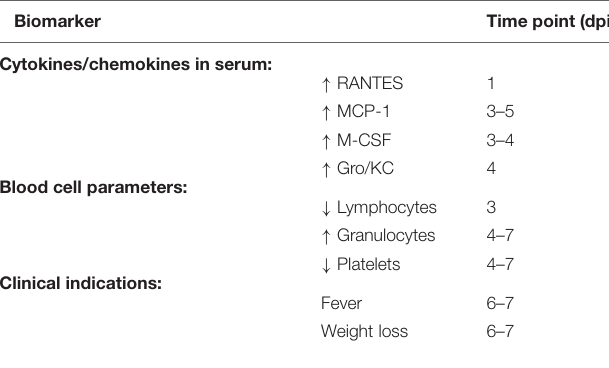
TABLE 2 | Biomarkers indicative of lethal neurological RVF in Lewis